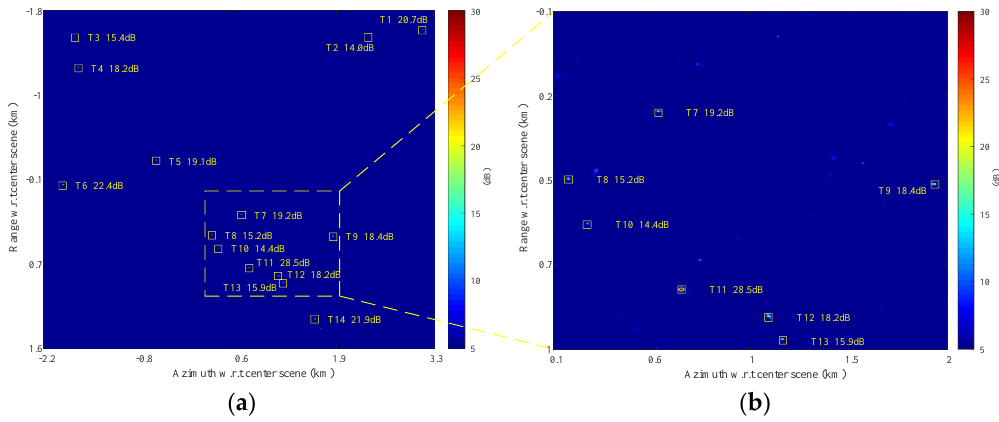
Figure 11. Clustering result of Figure 10: ( a ) full scene; and ( b ) magnified part of ( a ).